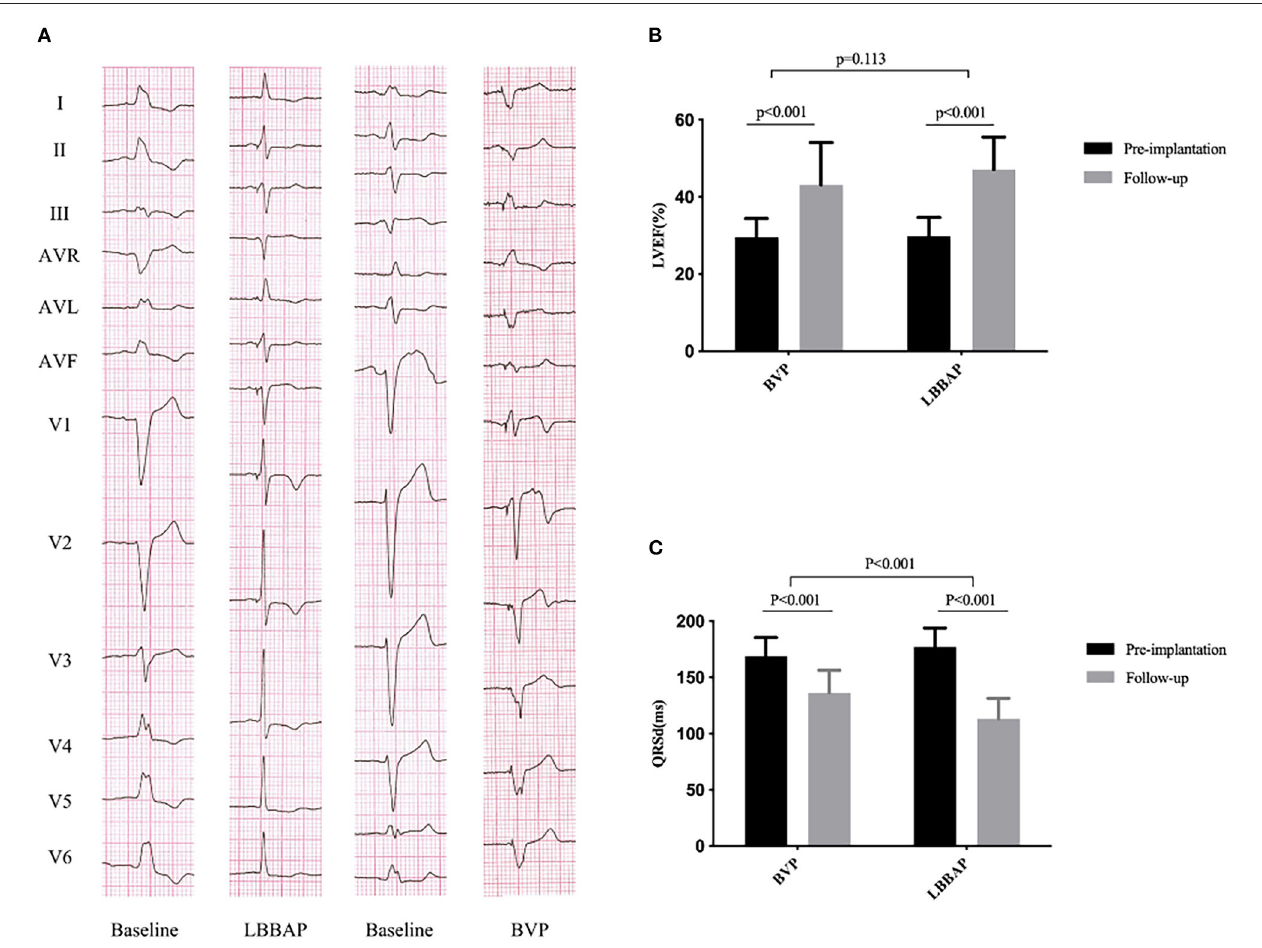
FIGURE 1 | QRS duration and cardiac function at baseline and follow-up in the BVP and LBBAP groups. (A) Twelve-lead ECG from baseline to follow-up; (B) left ventricular ejection fraction (LVEF) from baseline to follow-up; (C) QRS duration (QRSd) from baseline to follow-up.